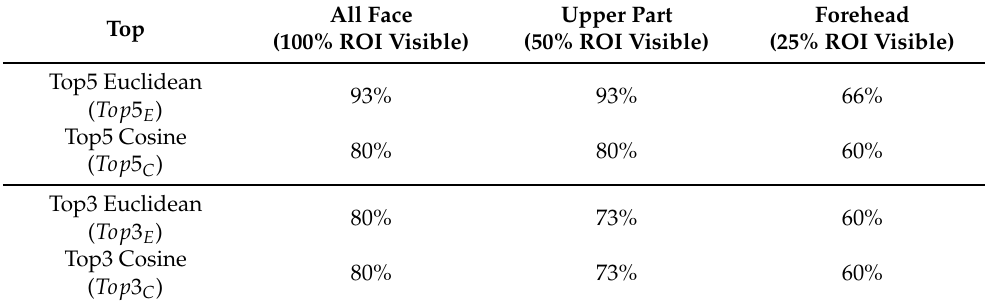
Table 1. Top5 and Top3 results obtained from the second layer of the C-SVM (depicted in percentage).